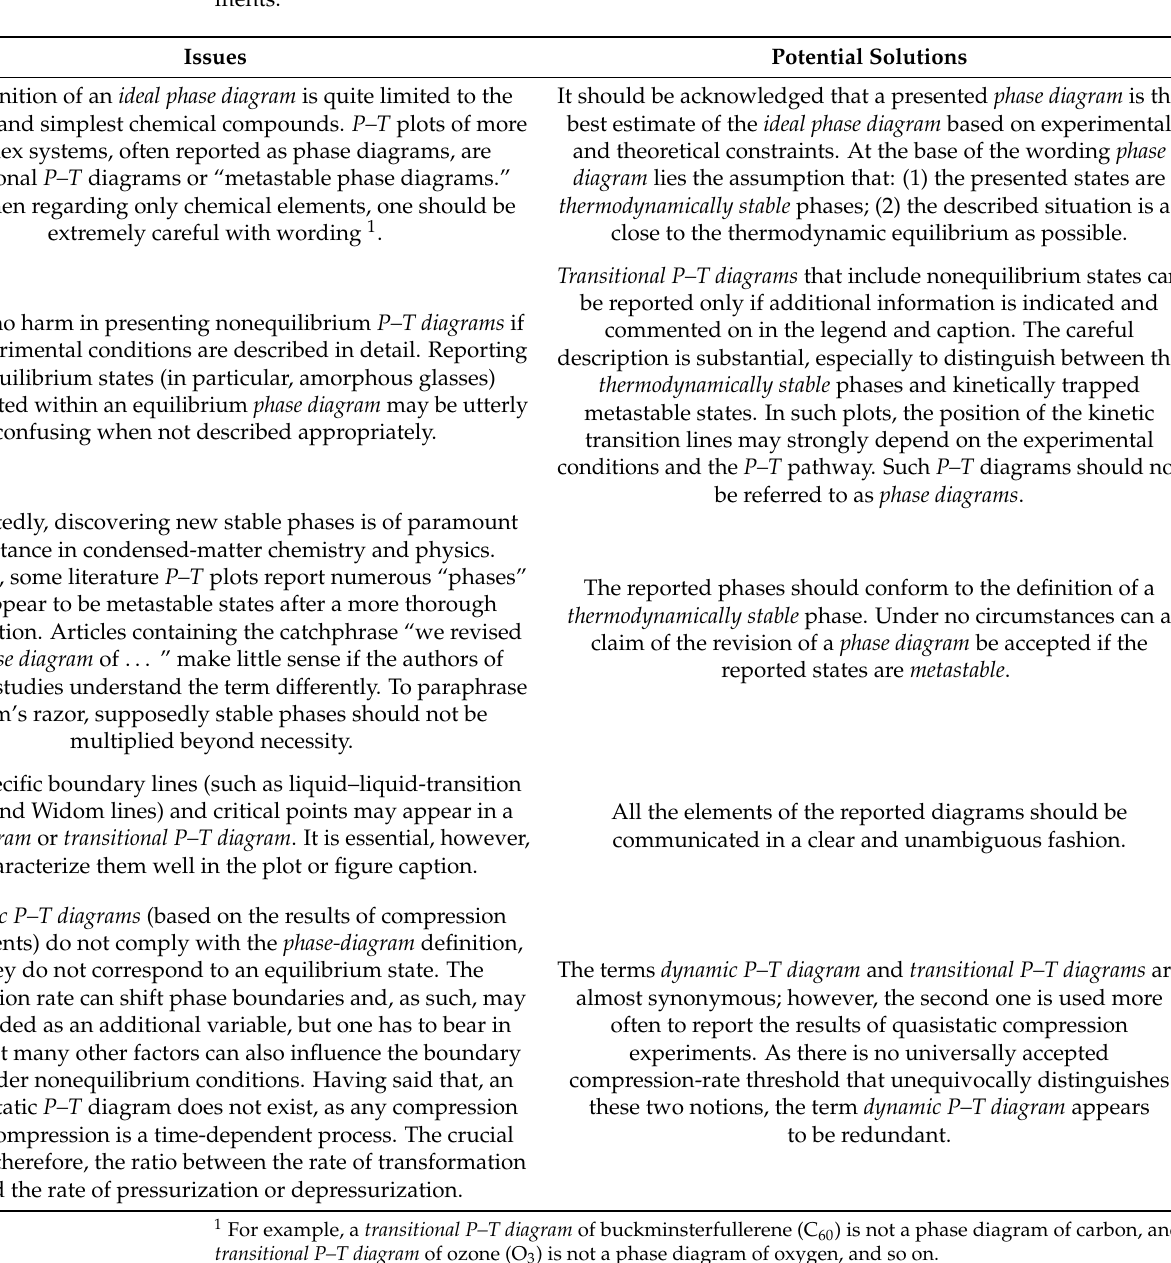
Table 1. The issues associated with the presentation of phase diagrams and suggestions for improve-